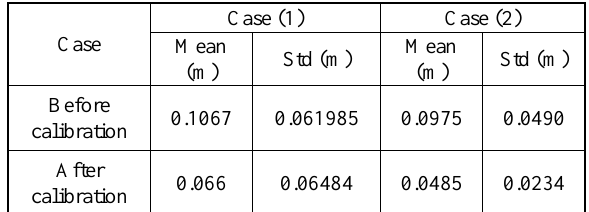
Table 3. The mean and the standard deviation of the distance between the LIDAR and images-driven point clouds before the calibration and after the calibration to test the cloud sparsity